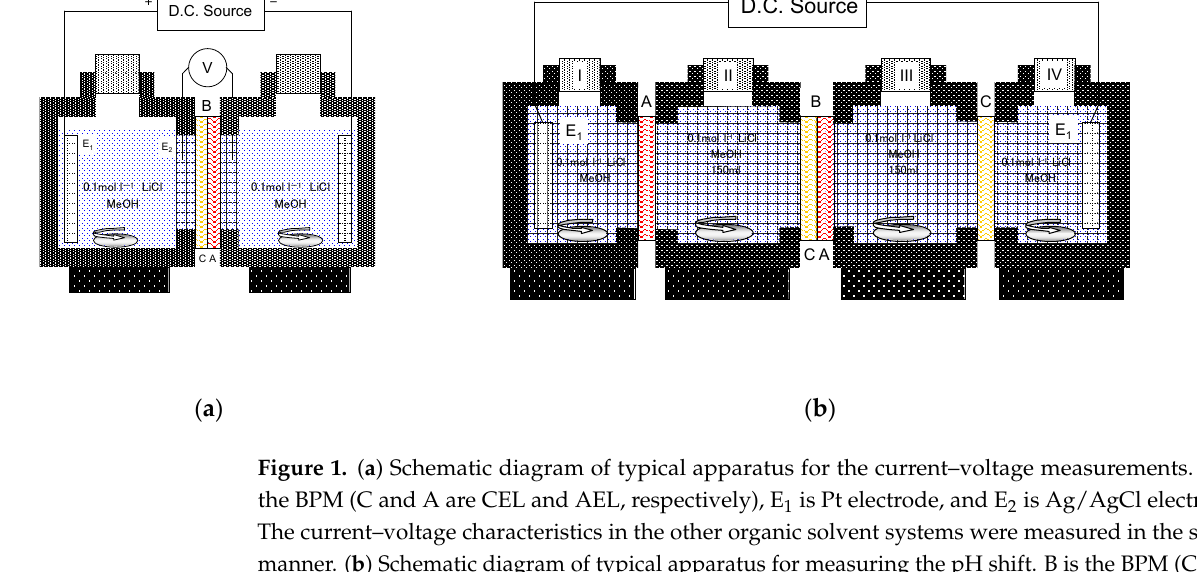
(Figure 1a) [8]. The BPM (Aciplex K501/A501 or K501/A201, effective area of 3.14 cm 2 ) was placed between the two compartments, which were both filled with 0.1 mol/L LiCl solutions. Both compartments were well-stirred using magnetic stirrers. The potential drop ( V measure ) across the BPM was measured by Ag/AgCl wire electrodes (diameter of 0.1 mm) placed on both sides of the membrane connected to a voltmeter (Fluke 45 Multimeter, Ev- erett, WA, USA) under conditions where a current was supplied by Pt-black disc electrodes connected to a DC current source/monitor (Advantest TR6143, Chiyoda-ku, Tokyo, Japan). All measurements were carried out at 25 ± 1 ◦ C. Under a reverse bias condition, both the current and voltage are negative and the curve is displayed in the third quadrant.